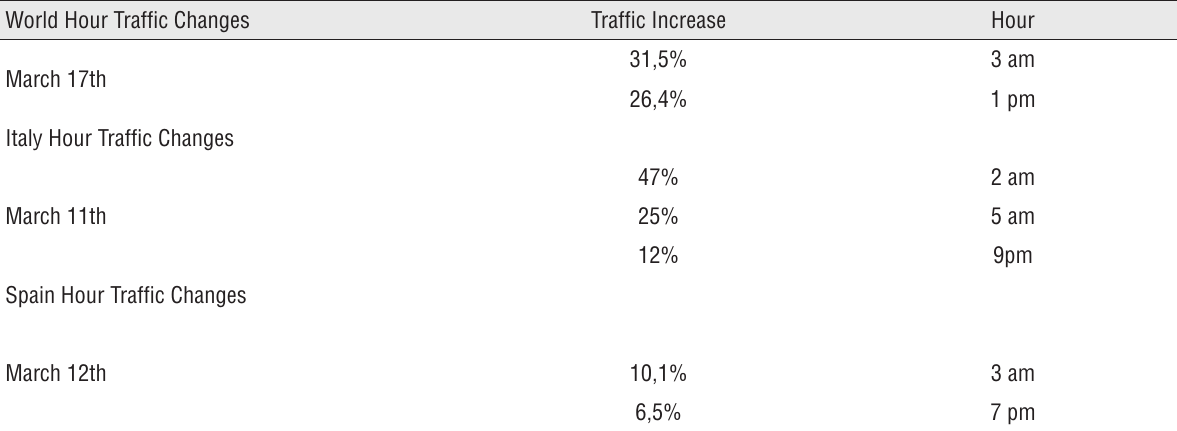
Table 1 - Worldwide Traffic to